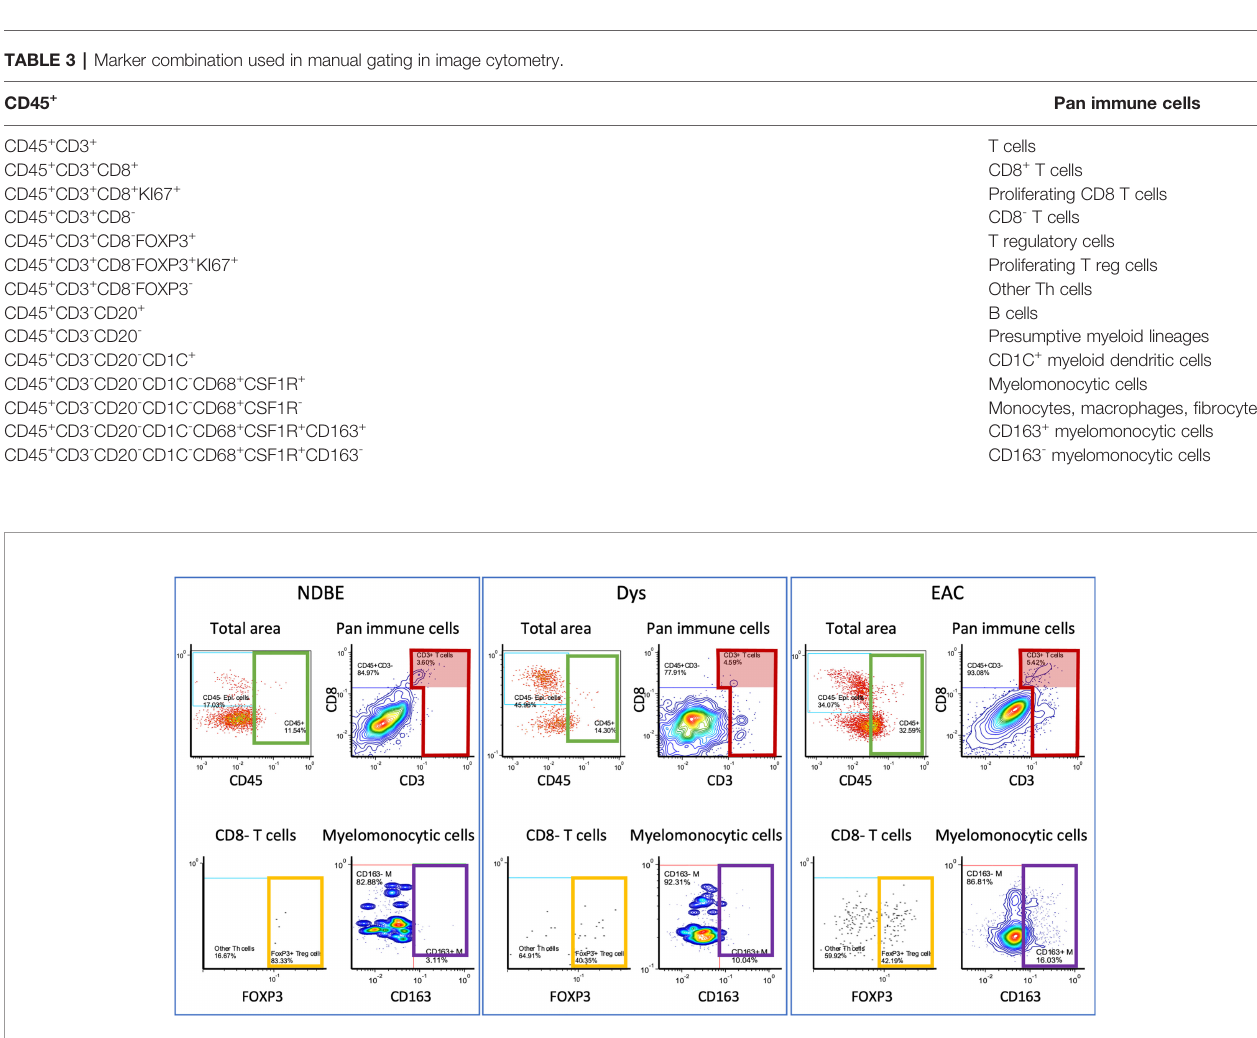
FIGURE 3 | Representation of manual gating in the image cytometry of NDBE, Dys, and EAC: green gate: CD45 cells for total cells for selected area; red gate: CD3 + cells from total CD45 + immune cells; red highlighted areas: CD3 + CD8 + cells; yellow gate: FOXP3 + Treg cells from CD45 + CD3 + CD8 - T cells; and purple gate: CD163 + myelomonocytic cells from total myelomonocytic cells (CD45 + CD3 - CD20 - CD1C - CD68 + CSF1R + ). Note the change of gated cells in different disease stages, see Figure S4 for gating